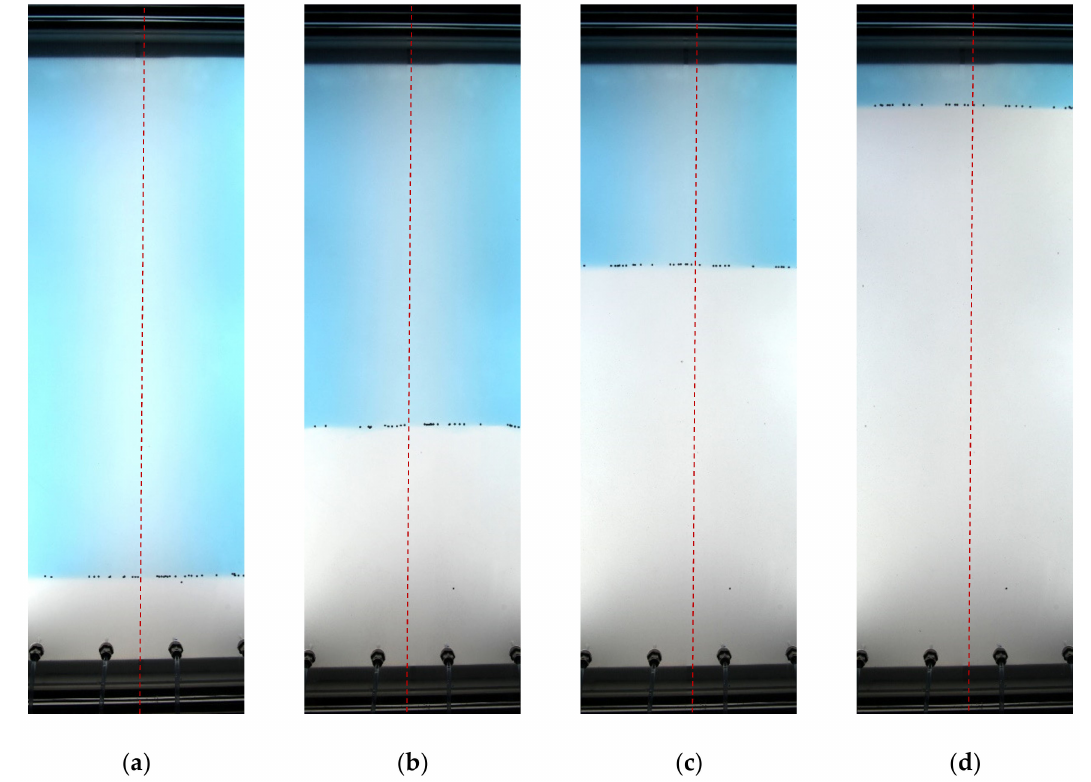
Figure 4. Snapshots of displacement flow in test no.1: ( a ) t = 0 s; ( b ) t = 5 s; ( c ) t = 10 s; ( d ) t = 15 s.